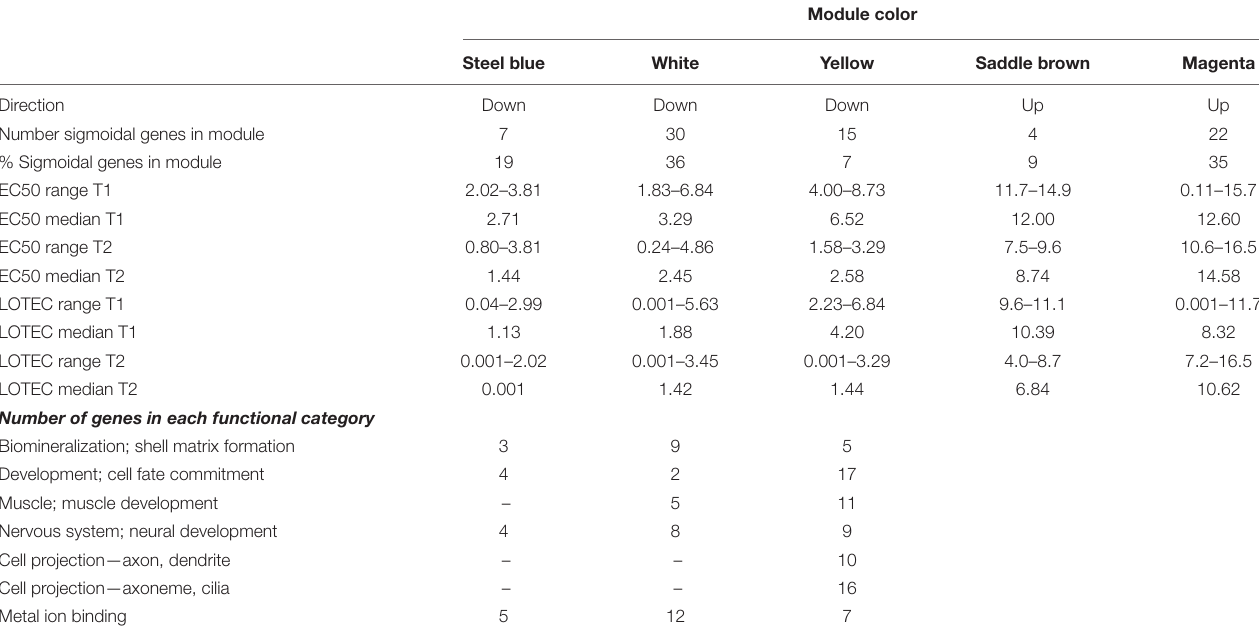
TABLE 1 | SDRS-defined characteristics of three sensitive downregulated modules and two significant upregulated modules, and the number of genes from each down regulated module that fall within notable functional categories that were well-represented among sigmoidal and modular genes.